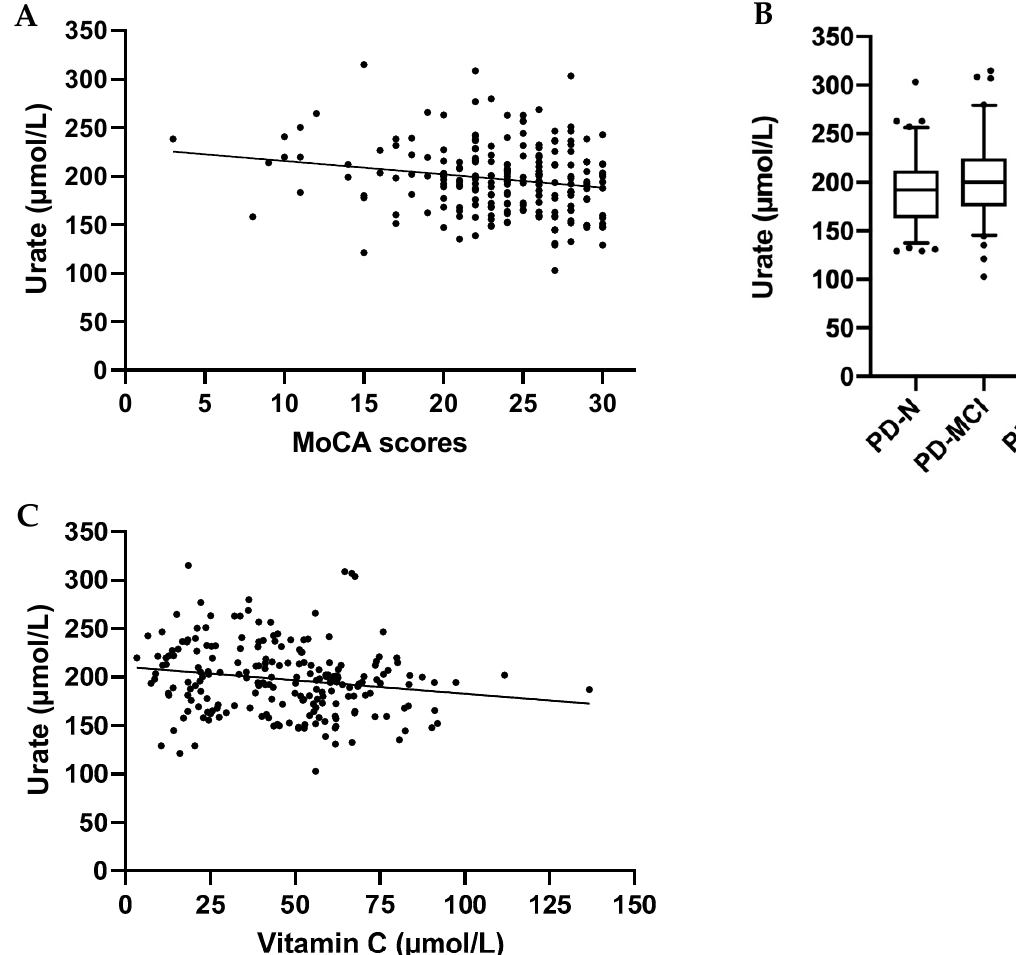
Figure 3. Plasma urate concentrations relative to cognitive function and plasma ascorbate status. ( A ) Montreal Cognitive Assessment (MoCA) scores in the Parkinson’s disease group ( n = 212) showed a significant inverse correlation with urate status ( r = − 0.19, p = 0.007). ( B ) Plasma urate concentrations in individuals with Parkinson’s disease as per cognitive status subgroups: normal (PD-N, n = 95), mild cognitive impairment (PD-MCI, n = 84), and dementia (PD-D, n = 34). The cognitively impaired group (PD-MCI and PD-D combined, n = 118) was significantly higher than the PD-N group ( p = 0.015). Box plots show medians with boundaries set at 25th and 75th percentiles, whiskers at 5th and 95th percentiles, outliers are indicated by symbols. ( C ) Plasma urate concentrations in the Parkinson’s disease group ( n = 212) show a weak inverse correlation with plasma ascorbate concentrations ( r = − 0.15, p = 0.017).